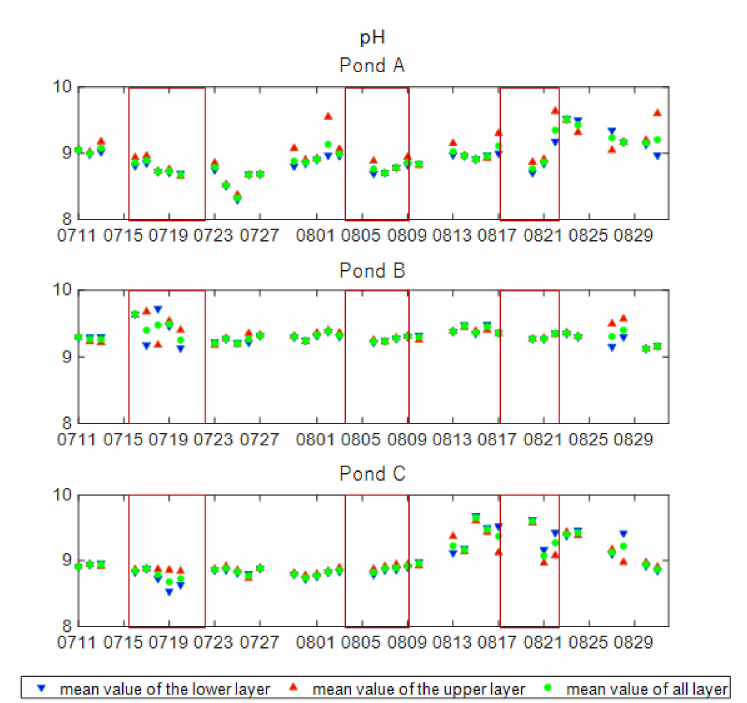
Figure 9. Mean pH value for the lower layer, upper layer, and all